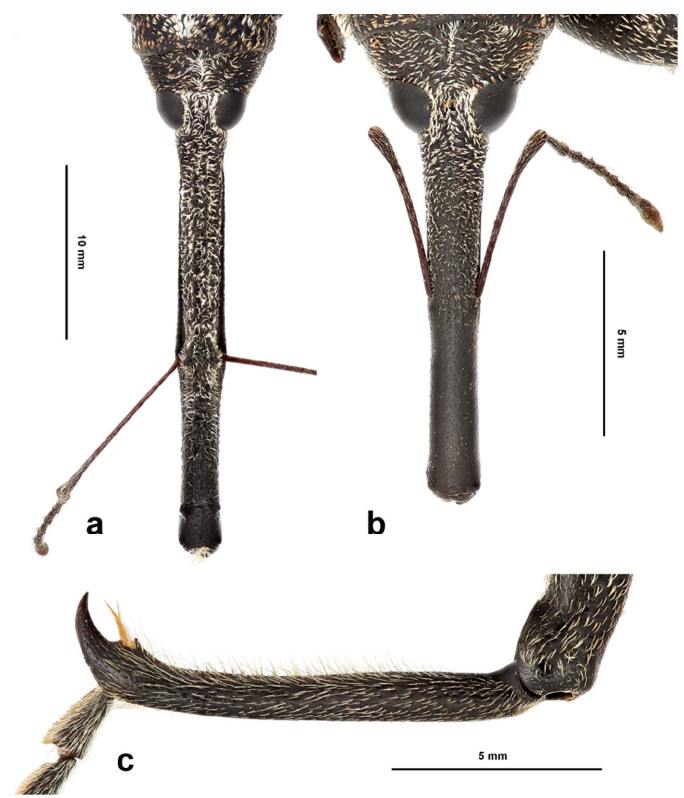
Figure 4. Eurhamphus fasciculatus : ( a ) rostrum of male, dorsal aspect; ( b ) rostrum of female, dorsal aspect; ( c ) protibia of male, anterior aspect.